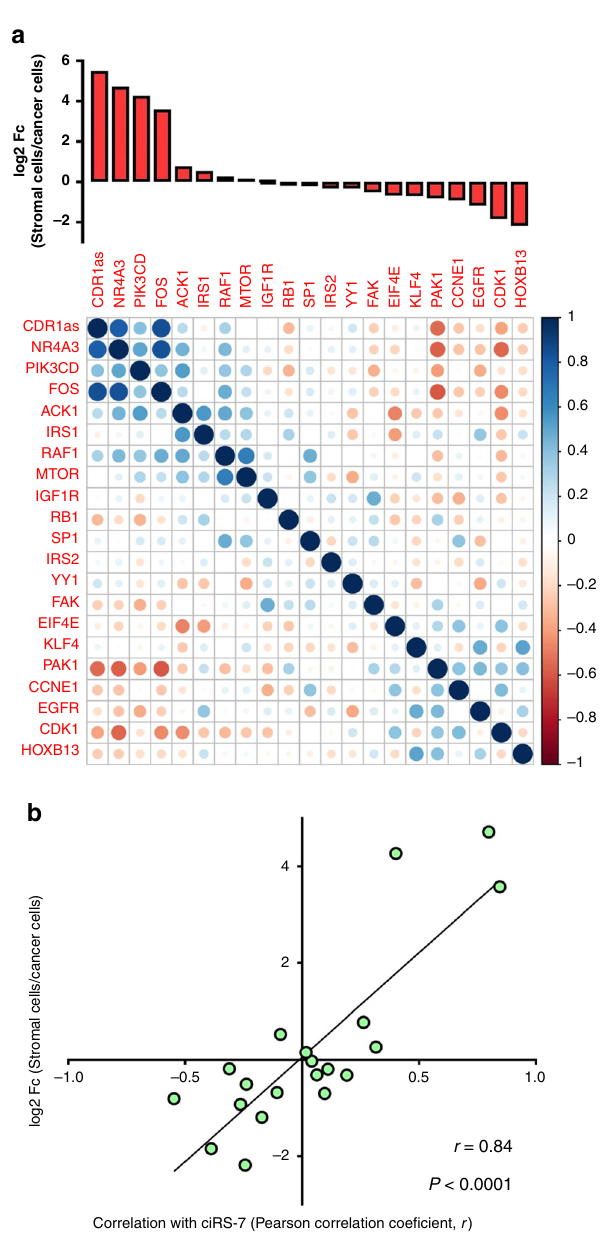
Fig. 4 ciRS-7 is positively correlated with stromal cell-enriched genes and negatively correlated with cancer cell-enriched genes. a Correlation matrix showing Pearson correlation coef fi cients between ciRS-7 and the 20 miR-7 target genes. The genes are listed according to relative expression levels in cancer and stromal cells, displayed in the top. These data were derived from fractions of stromal and cancer cells isolated by laser capture microdissection of colon cancer tissues, pooled from four individual representative patient samples ( n = 1). b Scatter plot showing log2 fold changes in stromal-to-cancer cell ratios ( y -axis) and correlation with ciRS-7 ( x -axis) for each of the 20 miR-7 target genes, with corresponding linear regression statistics, employing an F test to investigate if the slope was signi fi cantly non-zero, and Pearson correlation coef fi cient ( r